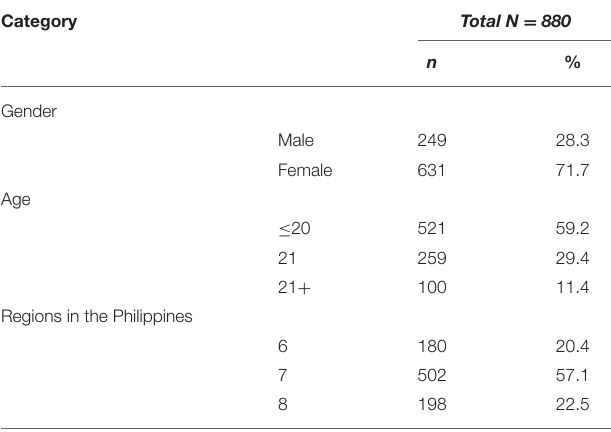
TABLE 1 | Demographic information of the participants ( N = 880).